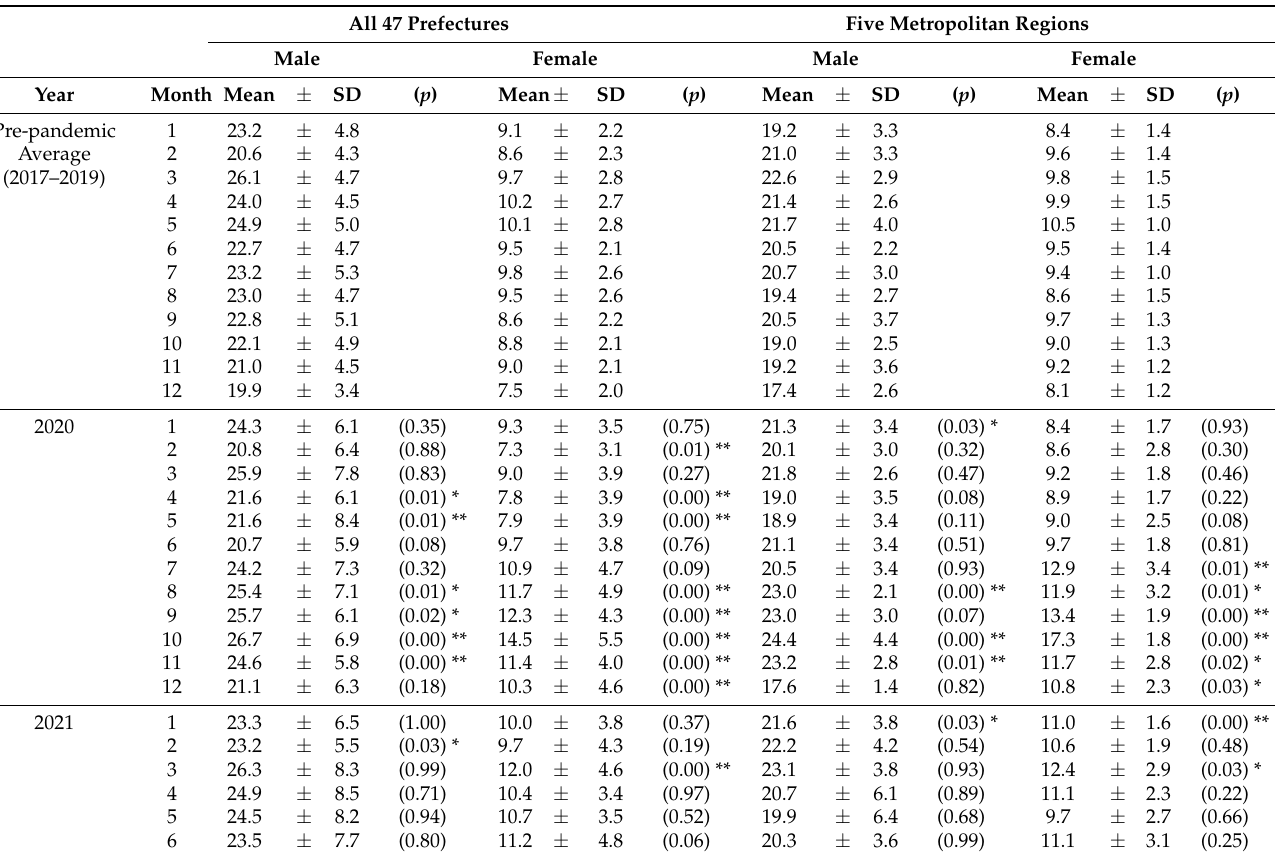
Figure 3. Comparison of annual and monthly standardised suicide mortalities (SMR-S) during COVID-19 pandemic period compared to the average of the same month of SMR-S during the pre-pandemic period (2017–2019), and the impact of the COVID-19 pandemic on SMR-S. Blue and red columns indicate significant decreasing and increasing suicide mortalities using a linear mixed-effects model with Tukey’s multiple comparison ( p < 0.05). Light blue and red columns indicate significant decrease and increase factors against SMR-S using hierarchical linear model with robust standard error ( p < 0.05). SMR-S: standardised suicide mortality per 100,000 people. SCR: standardised infection with COVID-19 per 100,000 people. SMR-C: standardised mortality caused by COVID-19 per 100,000 people. DCP: during COVID-19 pandemic. Table 1. Monthly standardised suicide mortalities (SMR-S) of males and females in all 47 prefectures and five metropolitan regions (per 100,000